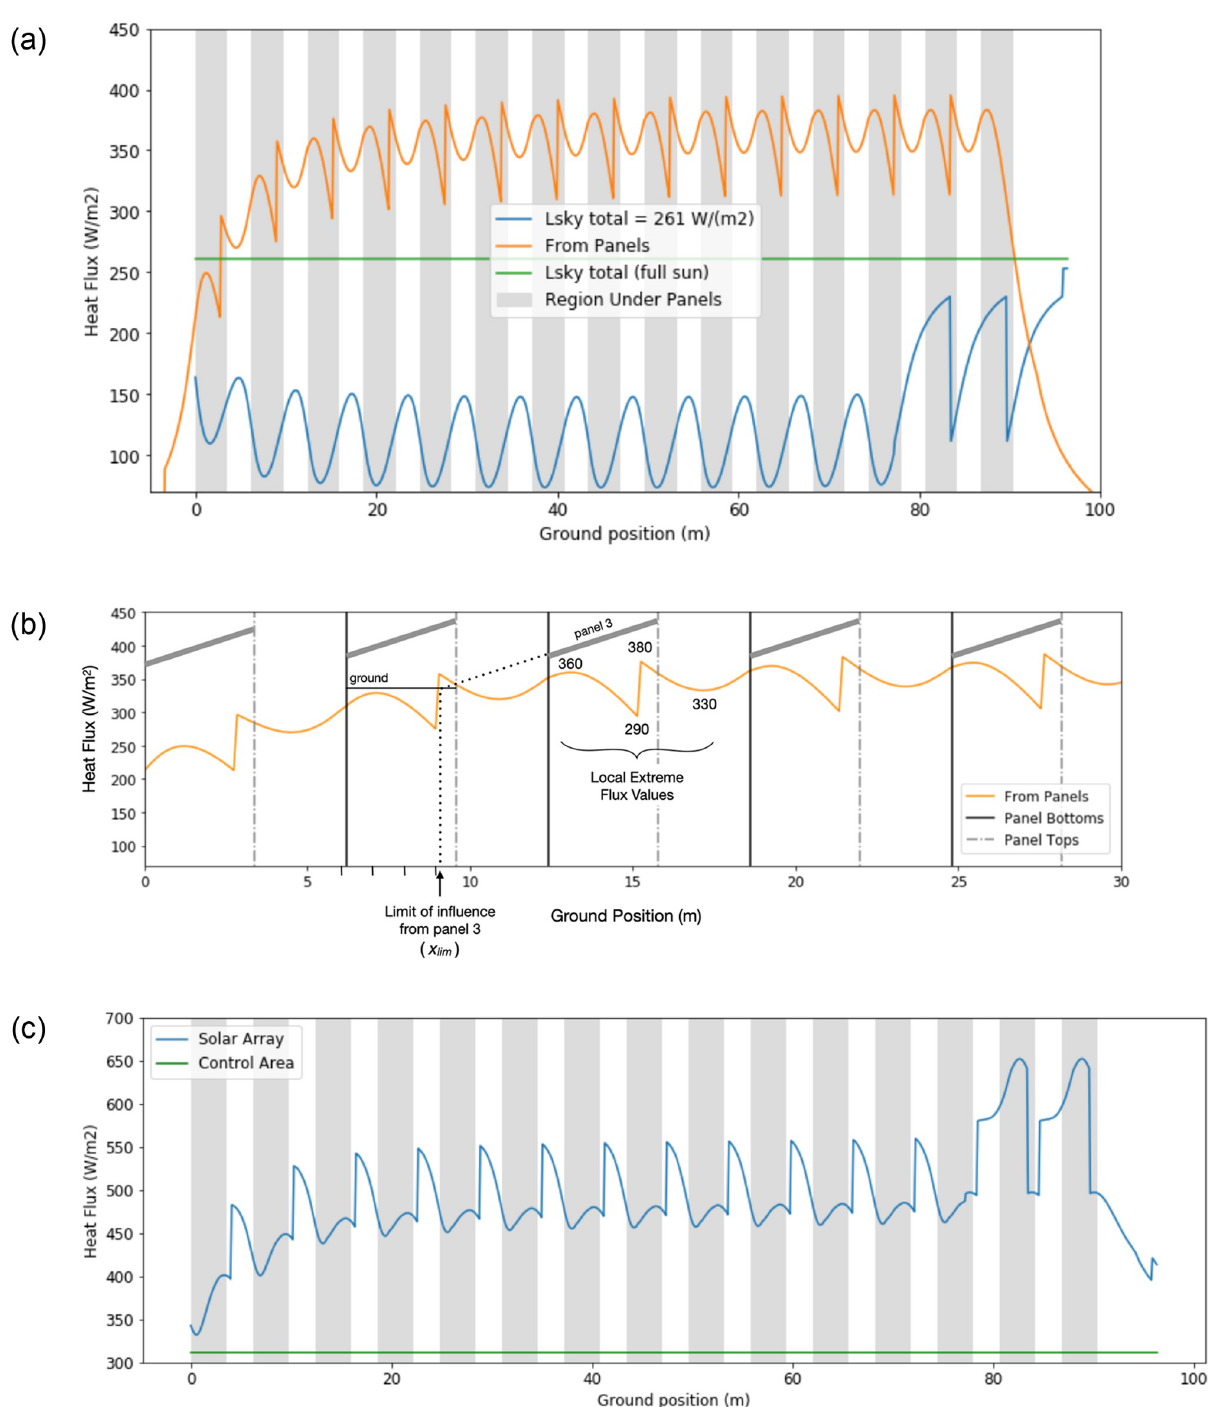
Fig 11. a. Components of the incoming longwave radiation at ground surface at t = 0 (May 6, 12am). b. Longwave from panels at t = 0 (May 6, 12am). c. Total incoming longwave radiation at ground surface at t = 0 (sum of the two lines in Fig 11a).